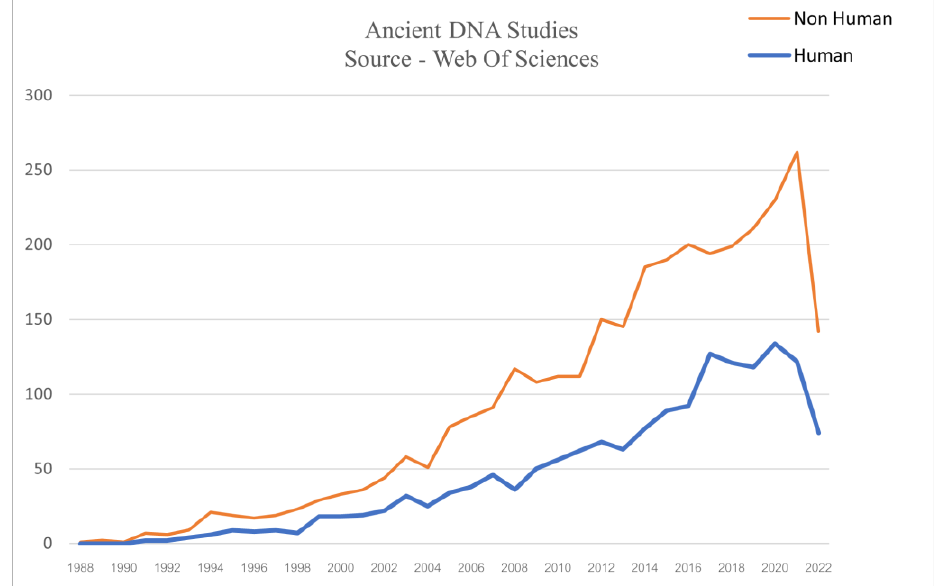
Figure 2. The total number of aDNA research articles (encompassing Sediments, Archaeological Artefacts and Ecofacts, Calcified and Mineralized substrates and Biological and Cultural archives) consists of 3187 non-human studies and 1588 human studies.